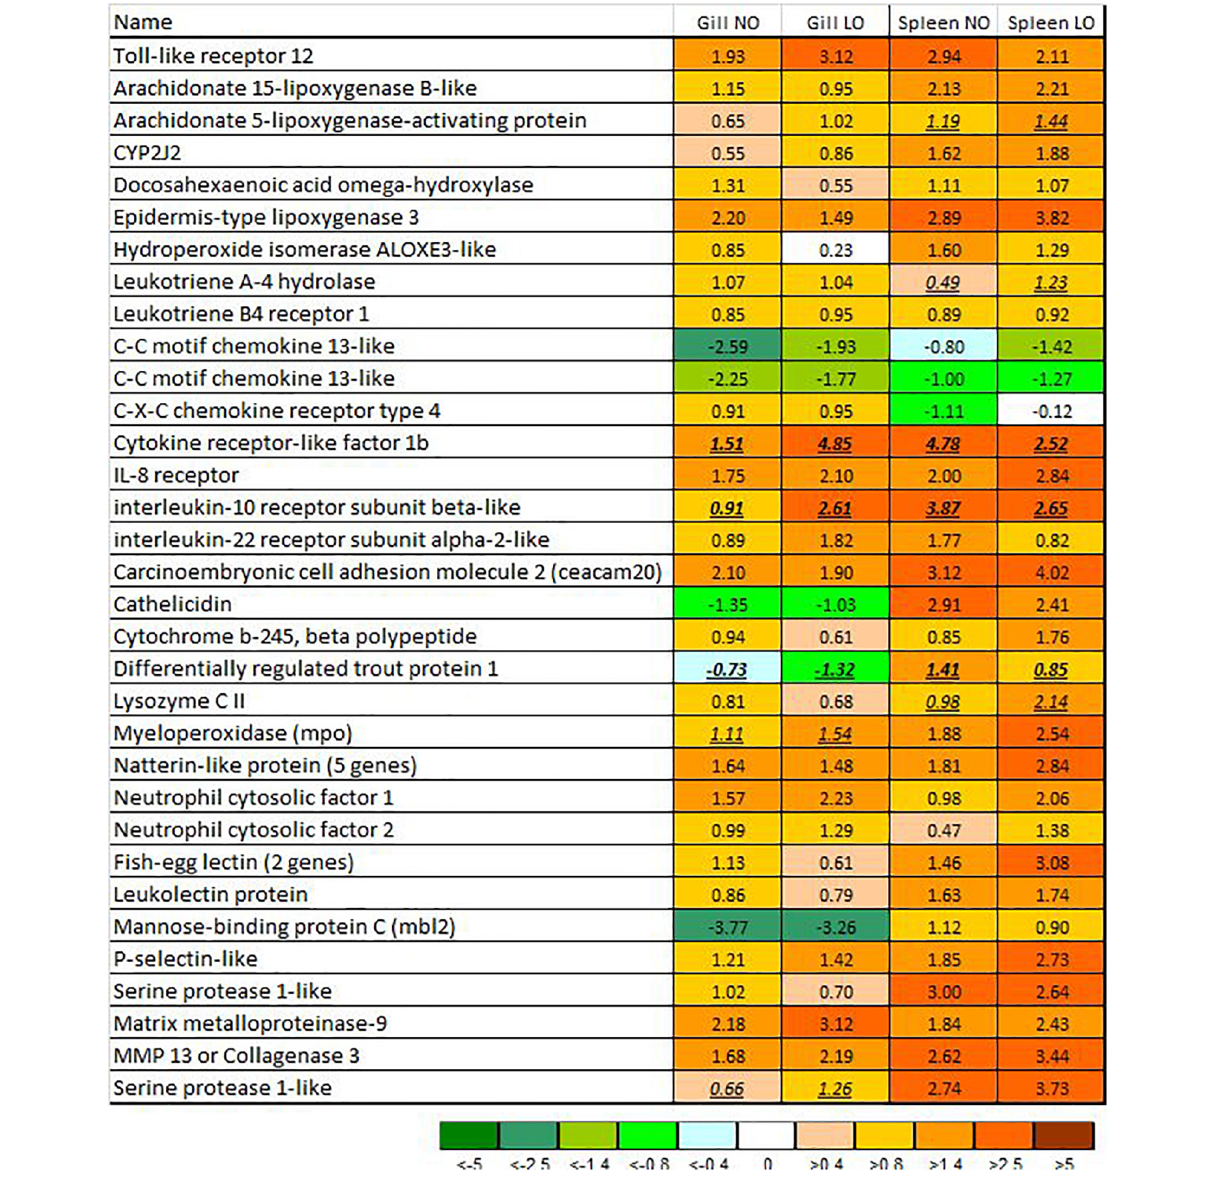
FIGURE 5 | Immune genes with responses to M. viscosa in gill and spleen (microarrays). Data are log2-ER (expression ratios of infected to uninfected fish). Differential expression is indicated with underlined italics. NO, LO – groups maintained at normal and low dissolved oxygen. The numbers of paralogs are indicated in